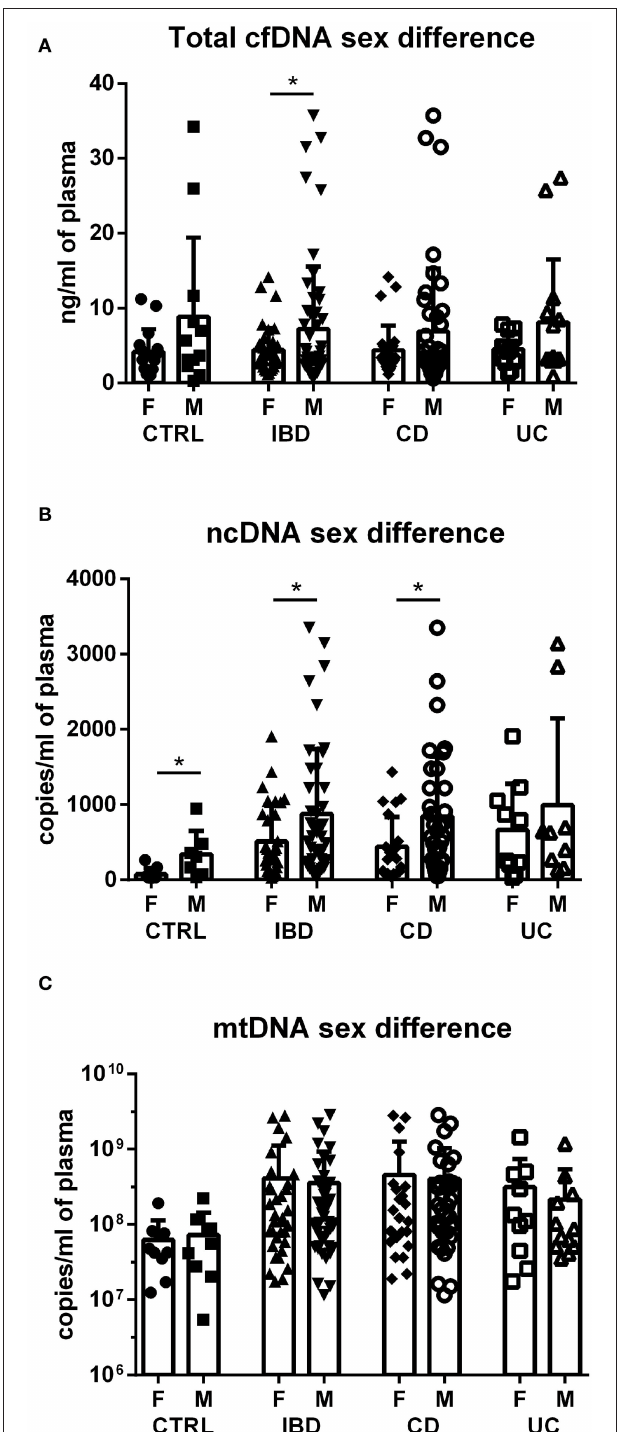
FIGURE 2 | Sex differences in cfDNA, ncDNA and mtDNA. Higher total cfDNA was found in male IBD patients compared with female patients ( p = 0.0478); however, this difference was not found in the subgroups of CD and UC (A) . Concentration of ncDNA is higher in males compared to females in healthy controls ( p = 0.0274), IBD patients ( p = 0.0345) and CD subgroup ( p = 0.0309) (B) . No sex difference was found in mtDNA in any of the groups (C)